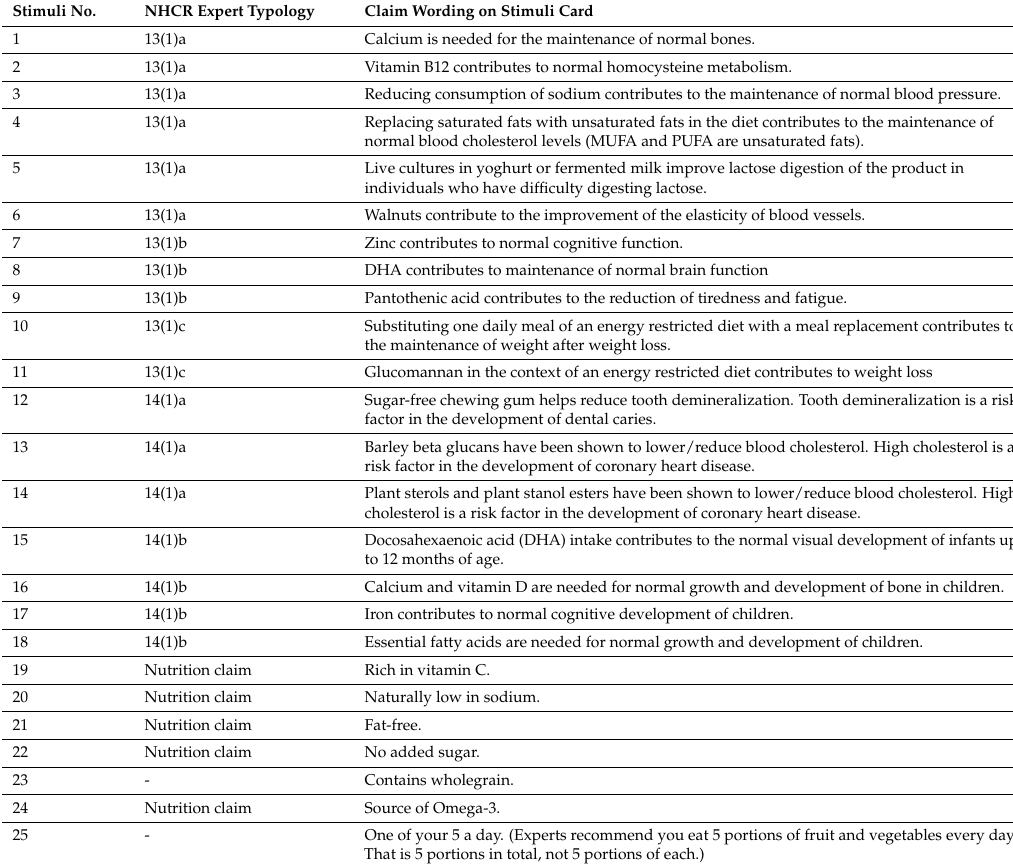
Table 3. Structured sort headings and associated stimuli cards.